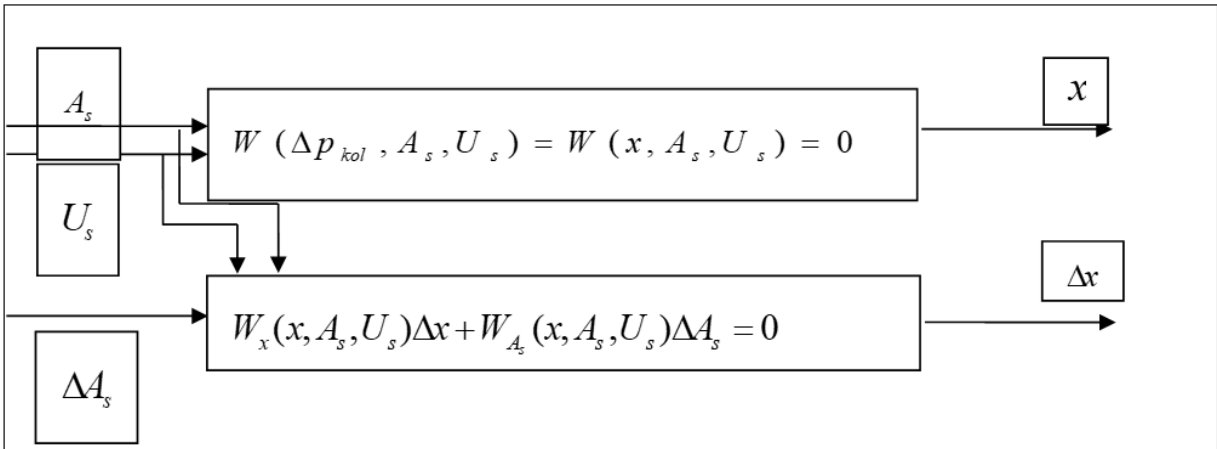
Figure 3. Vacuum drop model and related sensitivity model.